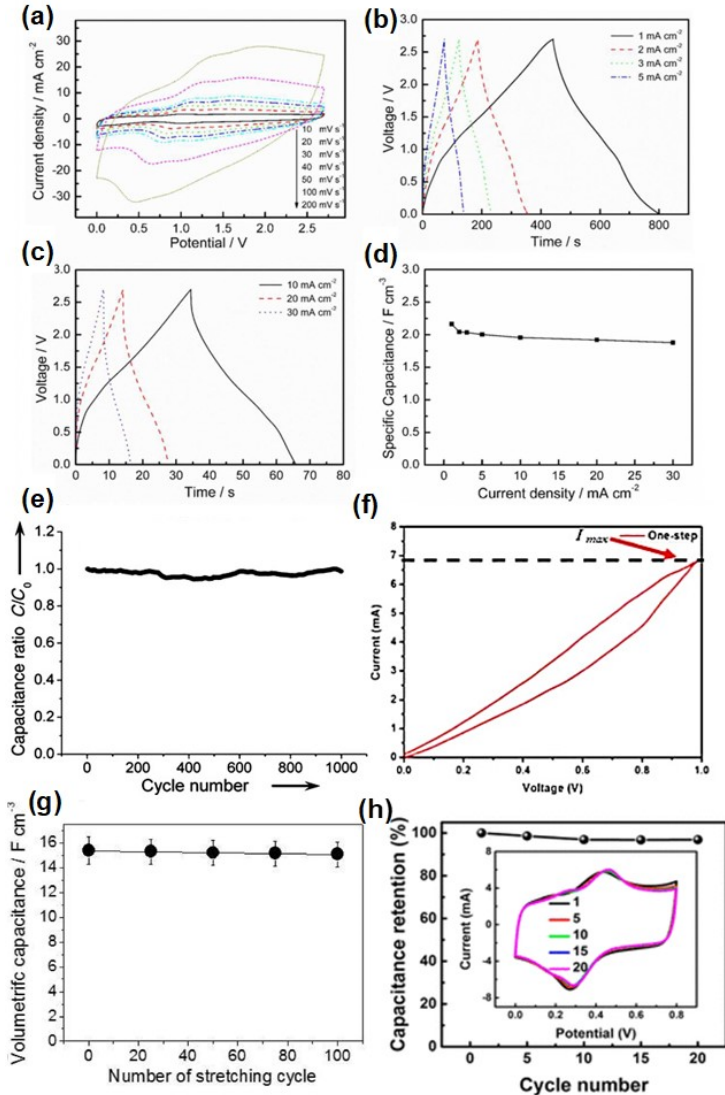
Figure 6. Electrochemical performance of ACM/MWCNTs@PDAA films with various polymeriza- tion charge densities measured in three-electrode mode in 1 M Et4NBF4–AN electrolytes. ( a ) CV curves at different scanning rates, ( b , c ) GCD curves at different current densities, ( d ) specific capac- itances versus current density [45], ( e ) change in capacitance of stretchable fiber supercapacitor un- der stretching cycles [51], ( f ) C-V curve of graphene oxide/natural rubber latex nanocomposites- based supercapacitor [52], ( g ) change in capacitance of CNT-deposited rubber nanofiber electrode- based supercapacitor as a function of stretching cycles [53] and ( h ) capacitance values of isotropic buckled CNT film-based supercapacitor after cyclic stretching [54]. Reproduced with permission from ref. [49,51–54].